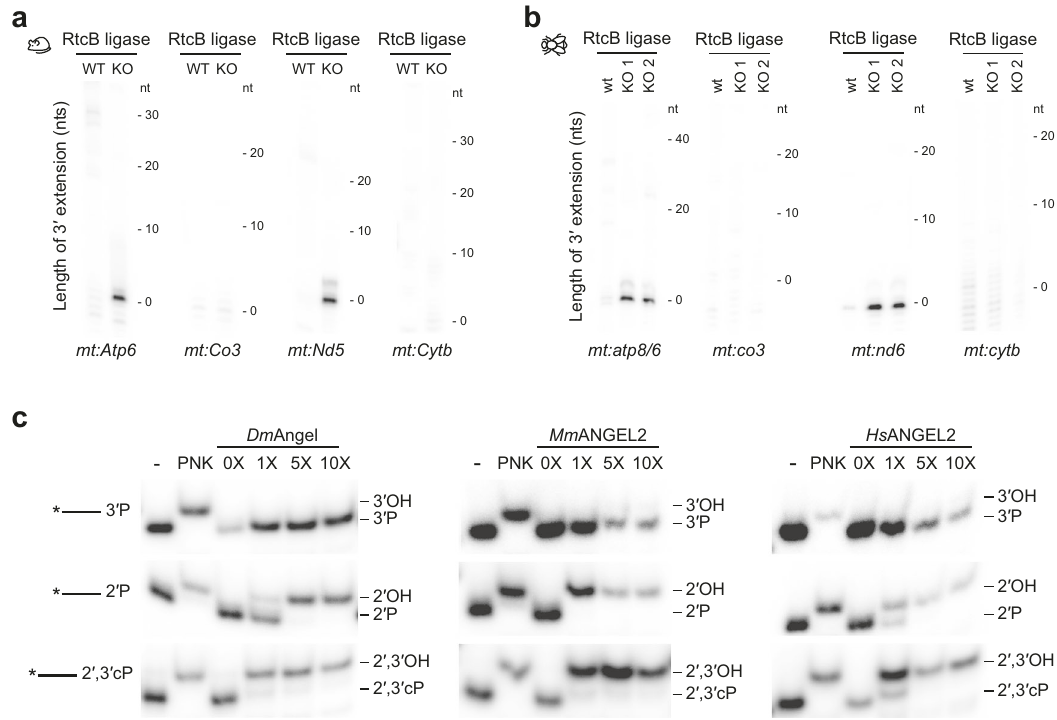
Fig. 4 | ANGEL2 and DmANGEL are terminal phosphatases in vivo and in vitro. MPAT length assay using RtcBligase in a MmAngel2 KO mouse heart or b DmAngel KO fl y samples. c In vitro phosphatase activity of recombinant Drosophila ( Dm Angel), mouse ( Mm ANGEL), or human ( Hs ANGEL) ANGEL or ANGEL2 protein, in the